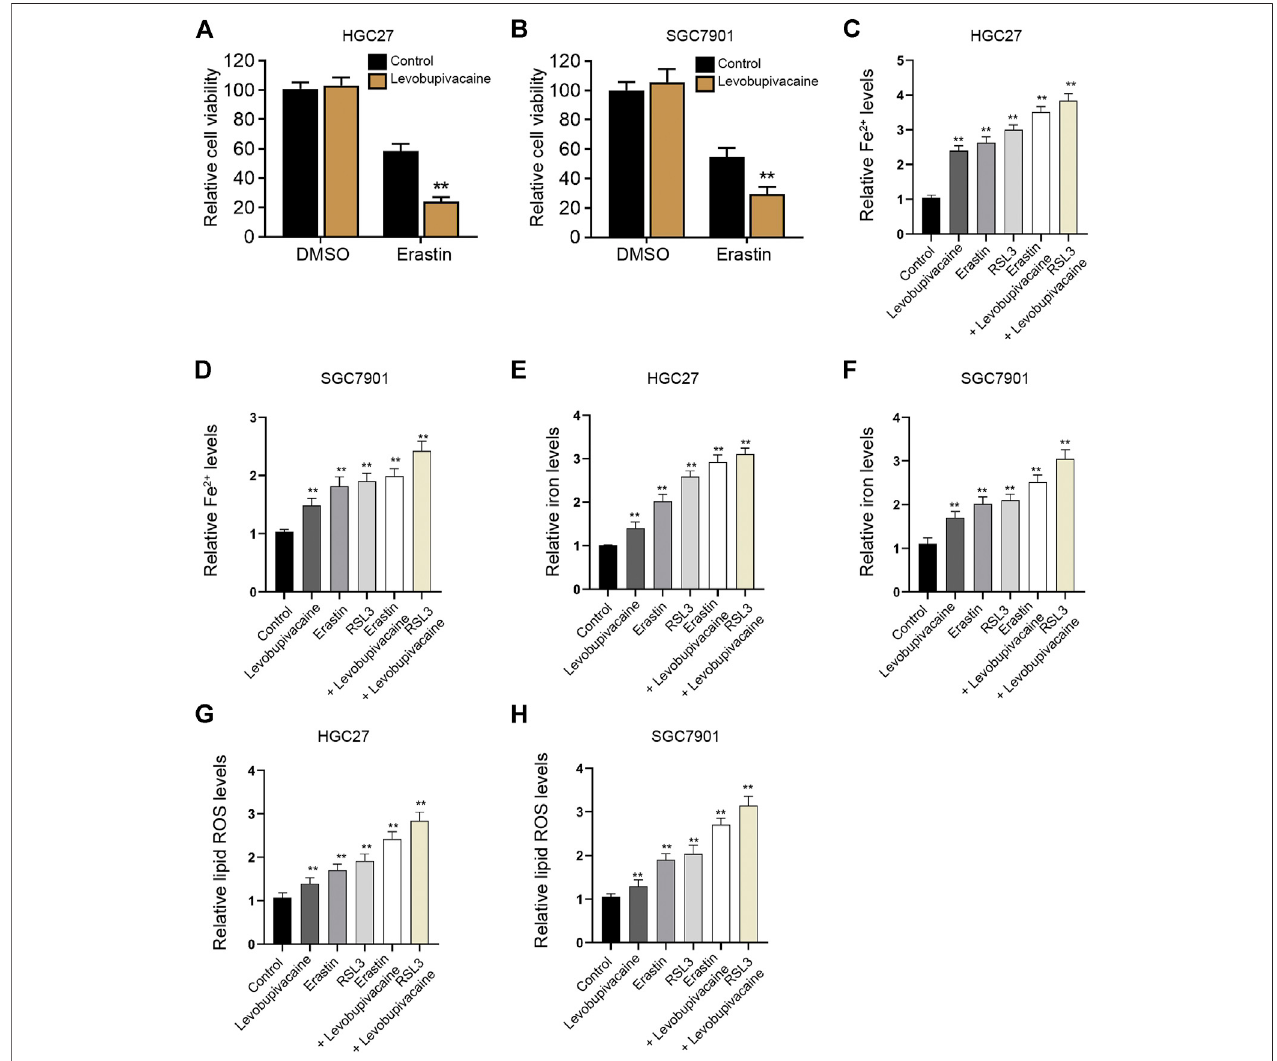
FIGURE 3 | Levobupivacaine enhances ferroptosis of gastric cancer cells. (A,B) HGC27 and SGC7901 cells were co-treated with erastin (5 μ M) and levobupivacaine (2 mM).MTTassaysforcellviabilityanalysis. (C – H) Theerastin(5 μ M)andRSL3(1 μ M)-stimulatedHGC27andSGC7901cellsweretreatedwithsalineorlevobupivacaine(2 mM). The Fe 2+ (C,D) , iron. (E,F) , and ROS levels (G,H) were analyzed. The experiments were performed independently three times (mean ± SD, ** p < 0.01).